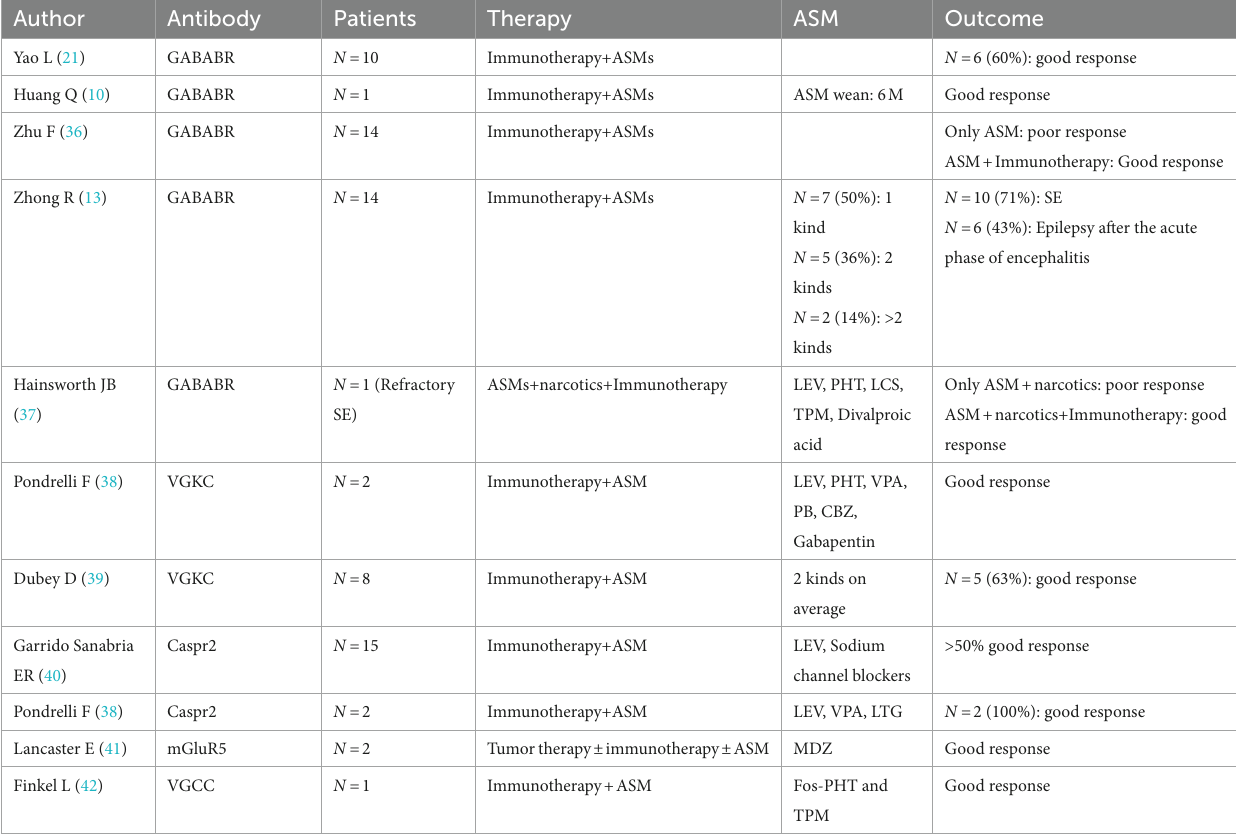
TABLE 7 Use of ASMs in anti-GABABR AE, anti-VGKC AE, anti-Caspr2 AE and other cell surface antibody-mediated AE.